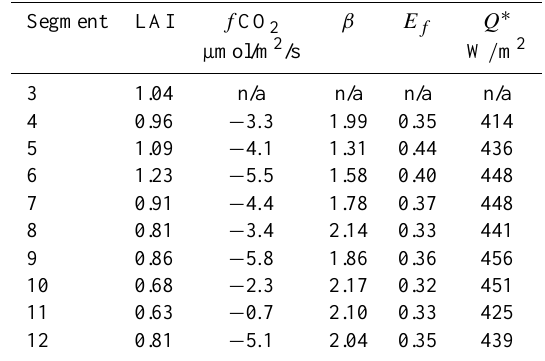
Table 4. Same as Table 3, except during IOP2 (7–14September) at